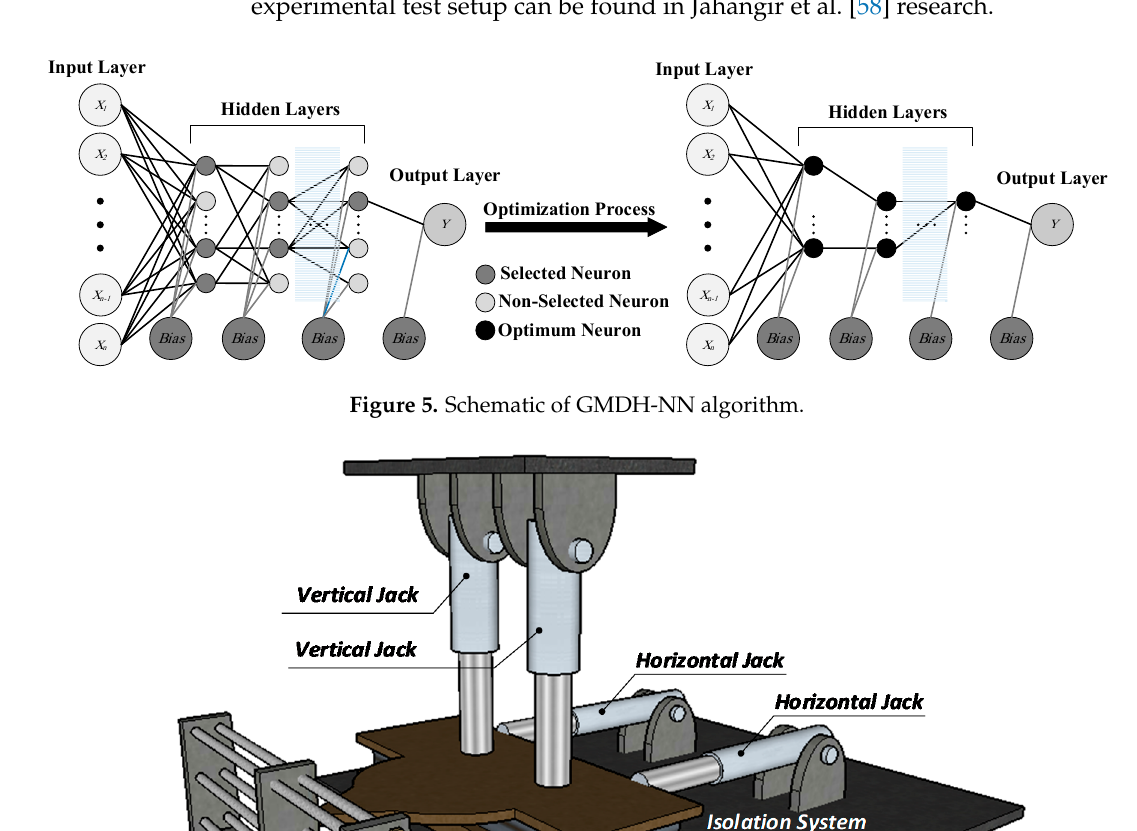
Figure 6. The test device of steel bar hysteretic damper and integrated isolator system.